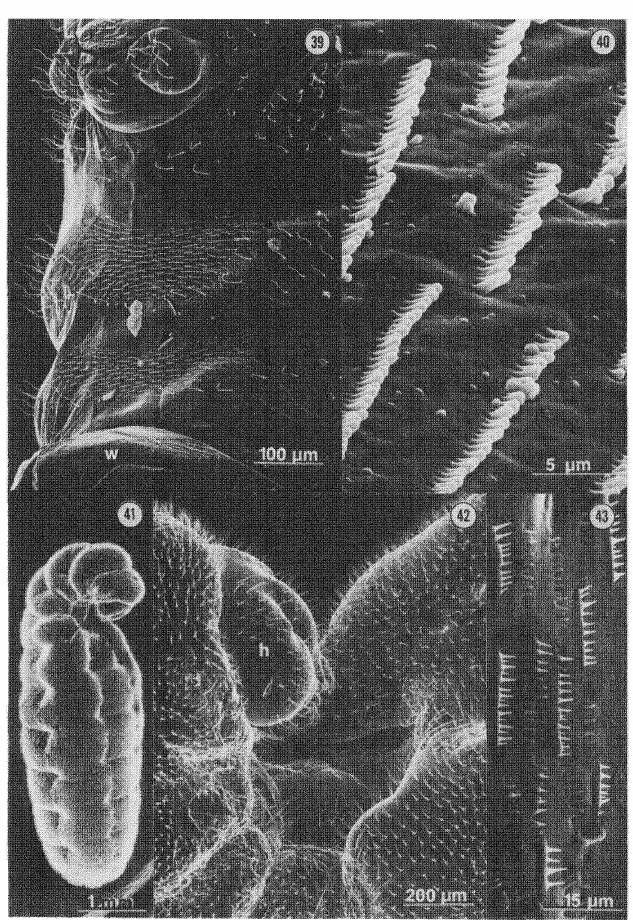
Figs. 39-43. Fig. 39. Anteroventral region of Colobopsis pylartes. Note rows of spinules (arrows) and welt (w). Fig. 40. Posteriorly pointing ventral thoracic spin- ules of C. pylartes magnified from Fig. 39. Fig. 41. Ventrolateral view of Campono- tus rasilis. Praesaepium (arrow). Fig. 42. High magnification of praesaepium of C. rasilis. Head (h). Fig. 43. Posteriorly pointing ventral thoracic spinules of C.